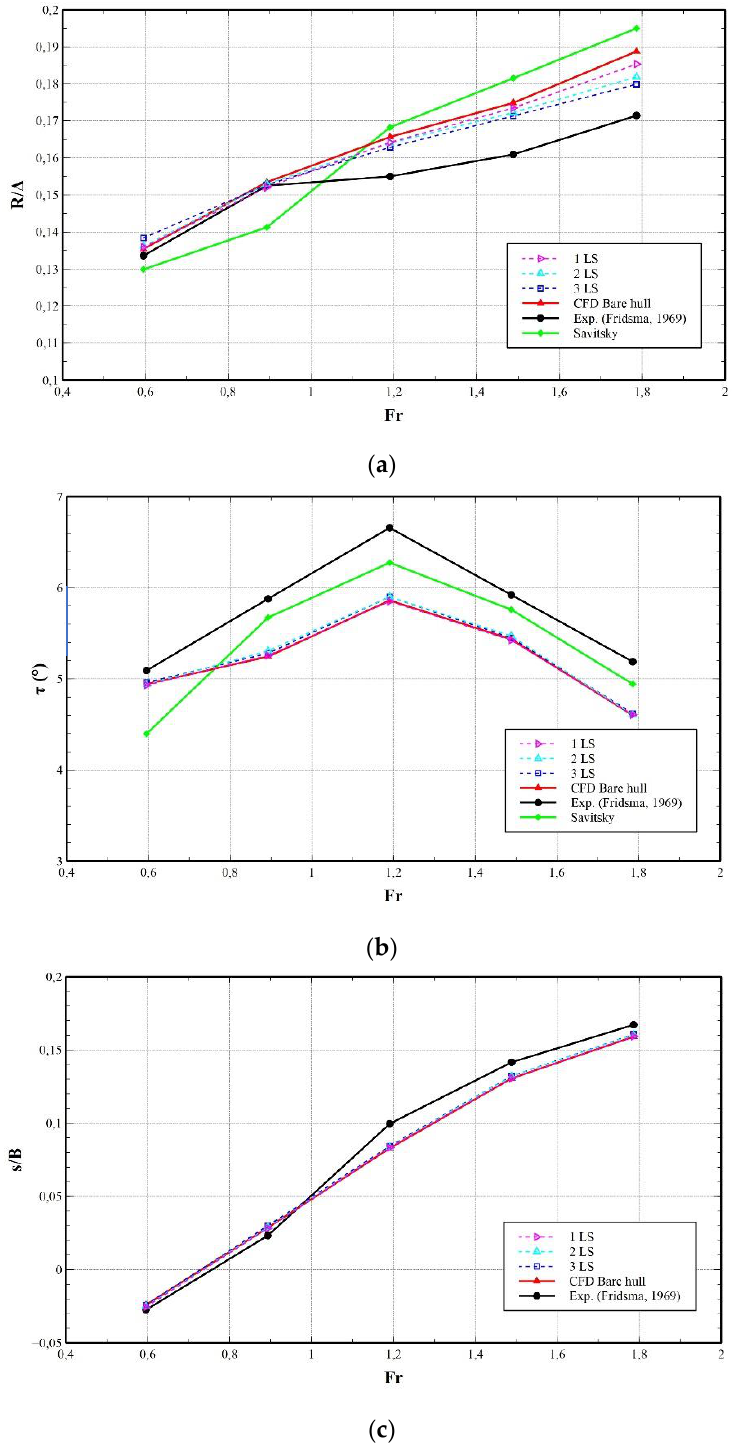
Figure 7. The effect of spray strips ( a ) resistance; ( b ) trim; ( c ) heave. Comparison of simulation results is reported using the CFD approach, Savitsky method, and experiments. The results of the simulation showed an acceptable trend. The difference in the gap between the CFD simulation results occurred at Fr > 0.89. Savitsky’s